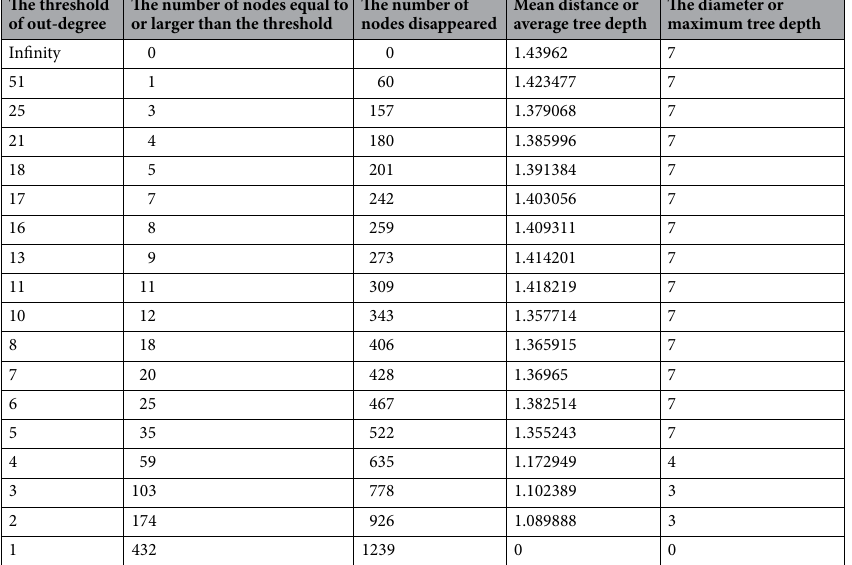
Table 3. The structure of the network after removing nodes based on